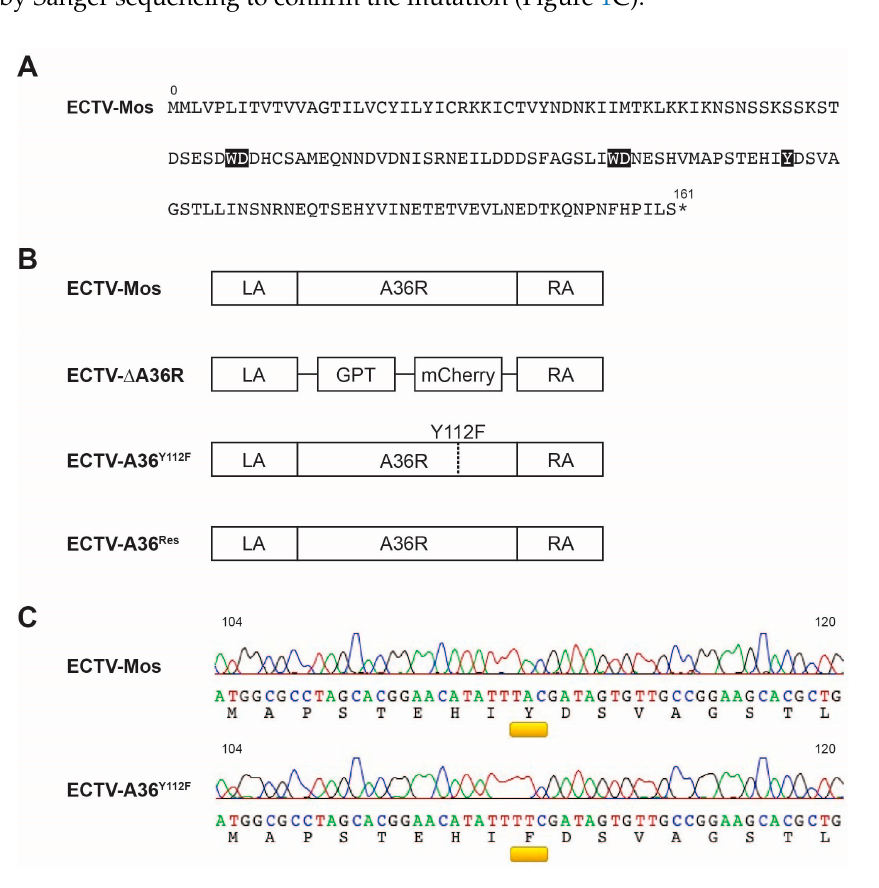
Figure 1. Schematic of Ectromelia virus (ECTV) A36 mutants: ( A ) Translation of the A36R open frame in ECTV-Moscow (ECTV-Mos). Highlighted are the Trp-Asp (WD) motifs for binding of kinesin-1 and the putative tyrosine phosphorylation site at position 112. ( B ) Schematic of the four ECTV viruses used in this study: the parental ECTV-Mos, ECTV- Δ A36, ECTV-A36 Y112F , and ECTV-A36 Res . ( C ) Sequencing reads of the A36R gene of the parental ECTV-Mos and mutated ECTV-A36 Y112F . Amino acid position 112 highlighted in yellow.